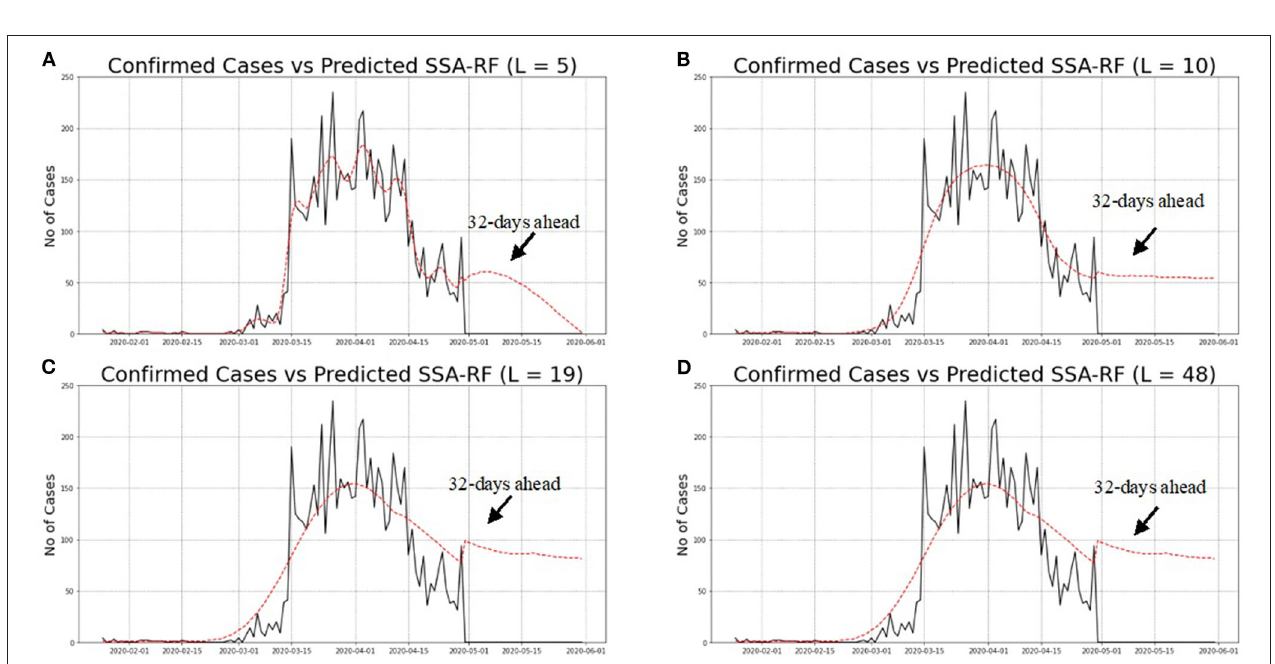
FIGURE 11 | (A–D) Predicted SSA-RF and confirmed cases of COVID-19 in Malaysia for Various Windows Length (L) .